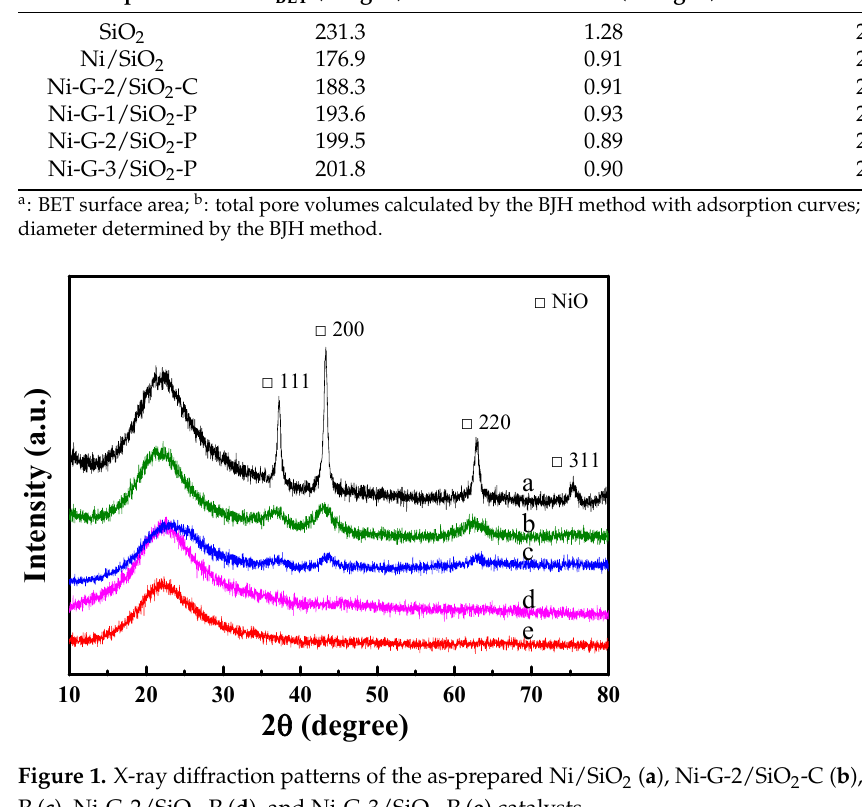
b c d e a Figure 2. X-ray diffraction patterns of the reduced Ni/SiO 2 ( a ), Ni-G-2/SiO 2 -C ( b ), Ni-G-1/SiO 2 -P ( c ), Ni-G-2/SiO 2 -P ( d ), and Ni-G-3/SiO 2 -P ( e ) catalysts. In order to verify the particle size and distribution of metallic Ni in the catalysts, the reduced Ni/SiO 2 , Ni-G-2/SiO 2 -C, and Ni-G-2/SiO 2 -P were subjected to TEM characteriza- tion. The obtained TEM images and particle size distribution of Ni are shown in Figure 3. Relatively larger Ni particle size, about 19.63 nm average particle size, and broad distri-